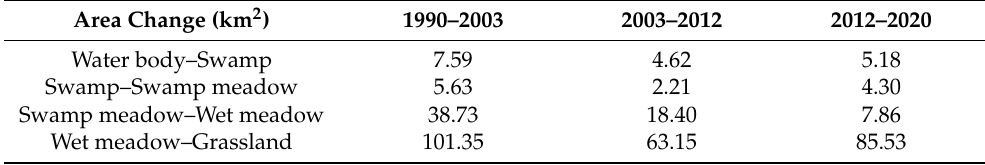
Table 6. Areas of conversion within wetland types during the different